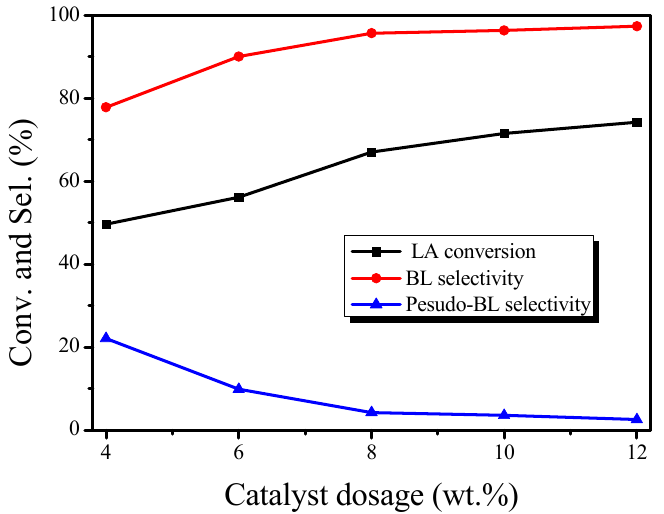
Figure 7. Influence of the catalyst dosage on the esterification of LA. Reaction conditions: LA: n-butanol = 1:10, reaction time: 6 h, and reaction temperature: 120 °C.